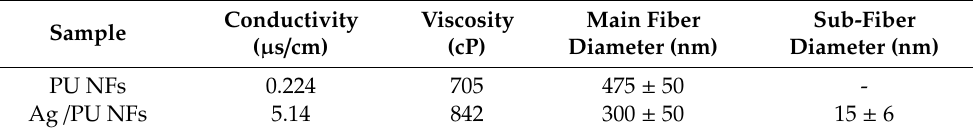
Figure 1. FE-SEM images of pristine PU NFs ( A ) and Ag/PU composite nanofibers ( B ). ( C ) and ( D ) are their respective Bio-TEM images. The inset in ( D ) shows the Ag NPs embedded in the nanofiber. Table 1. Conductivity, viscosity, and fiber diameters of the di ff erent